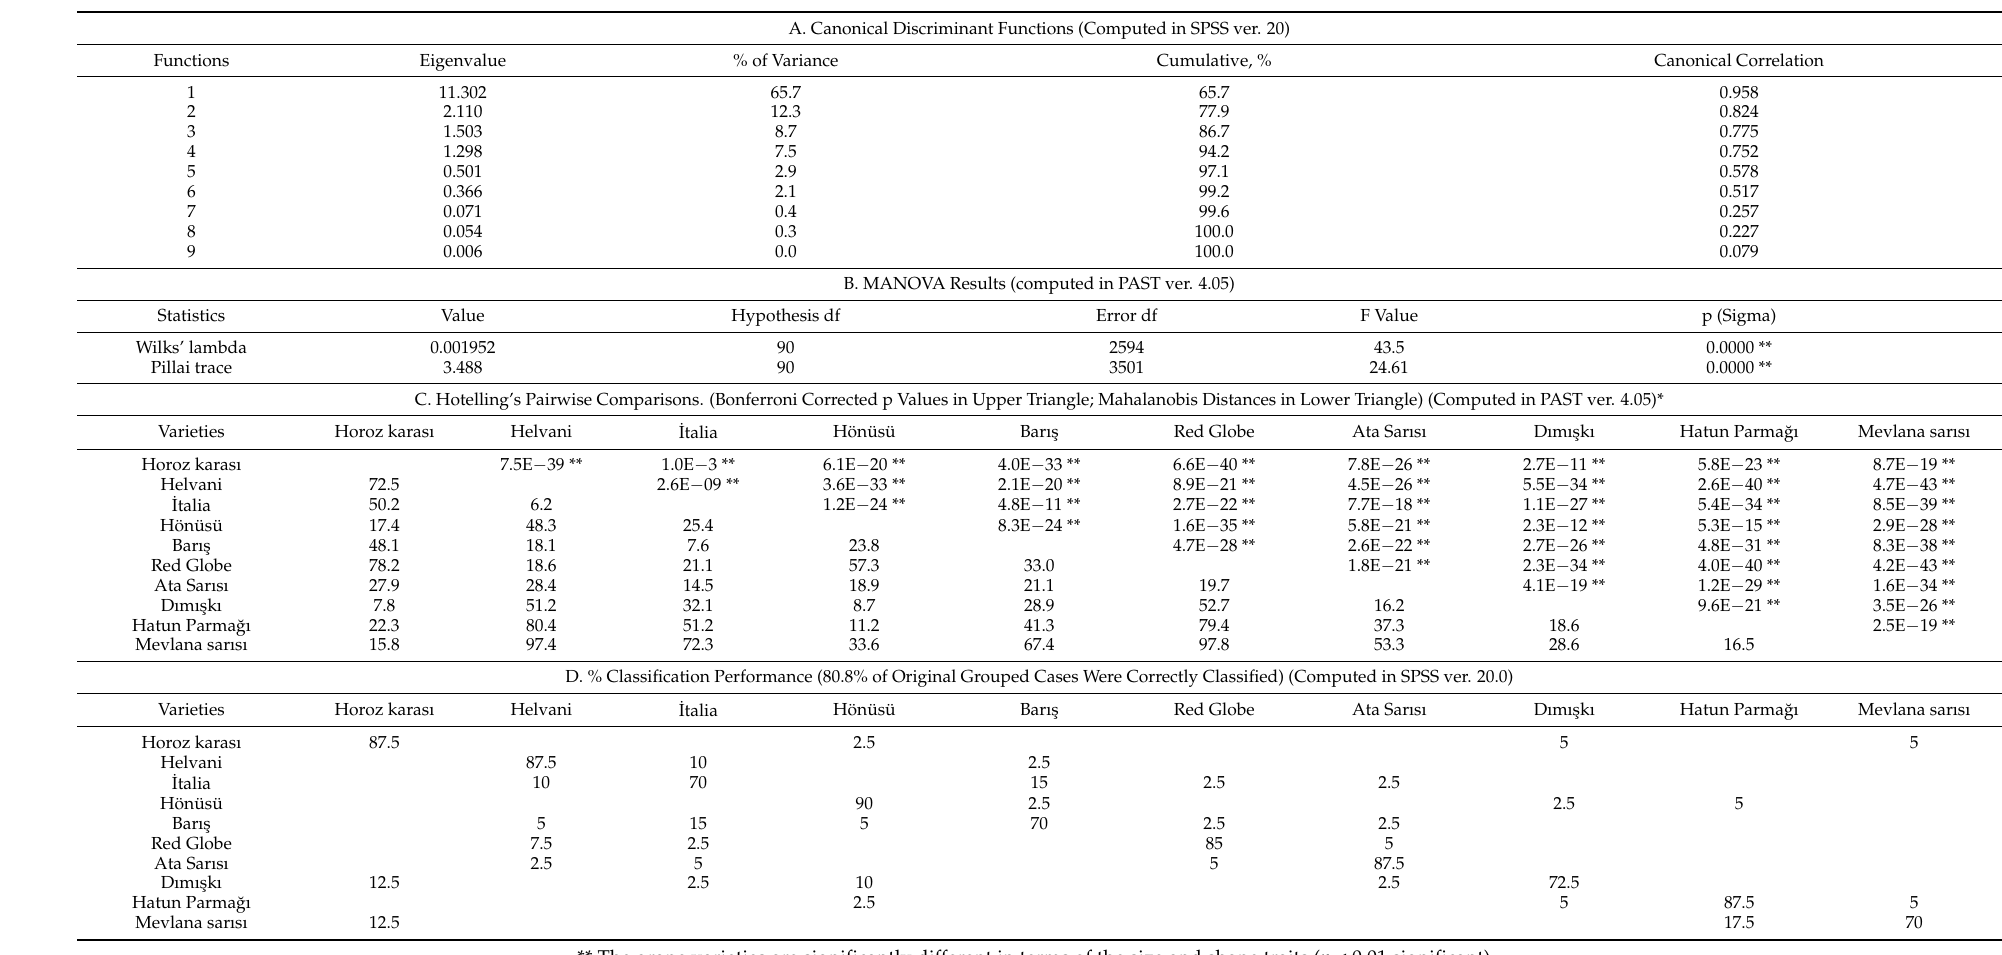
Table 5. The results of the discriminant analysis and pairwise